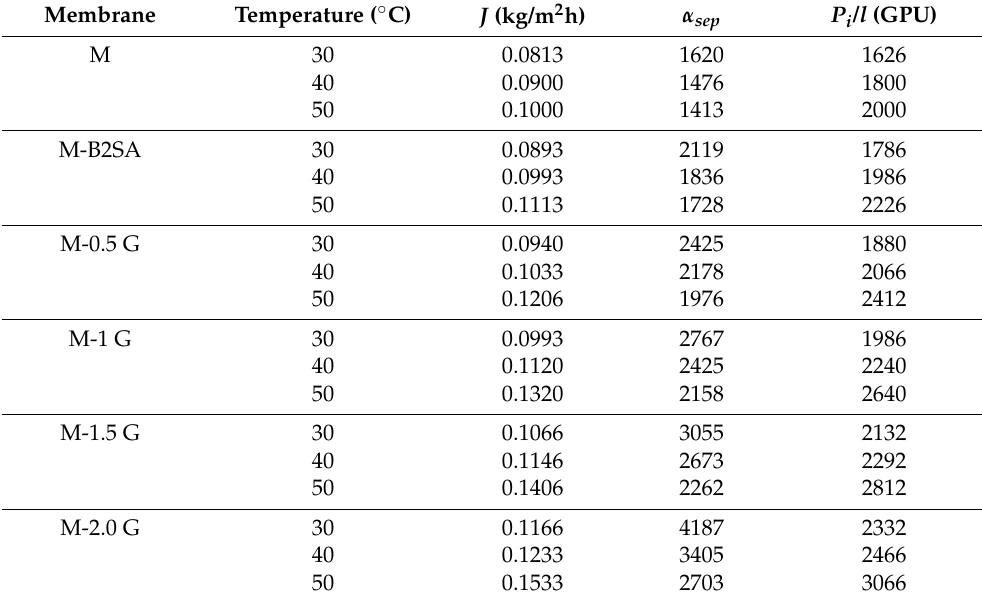
Table 4. Permeation flux, separation selectivity, and permeance data of the developed membranes at various temperatures a